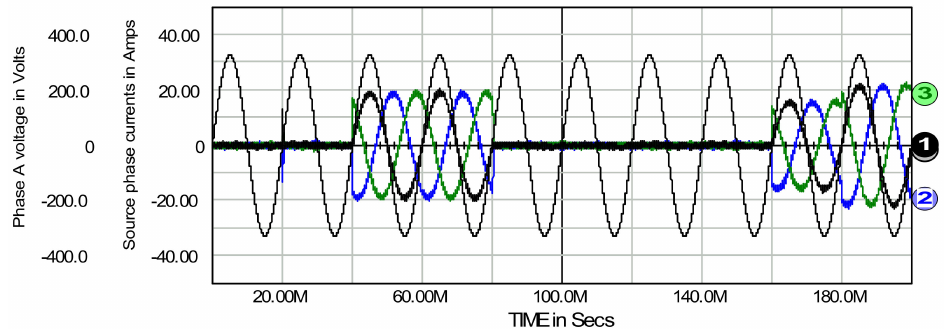
Figure 11. Source phase currents of phase A, B, and C as waveforms 1, 2, and 3, respectively, against the background of source voltage.